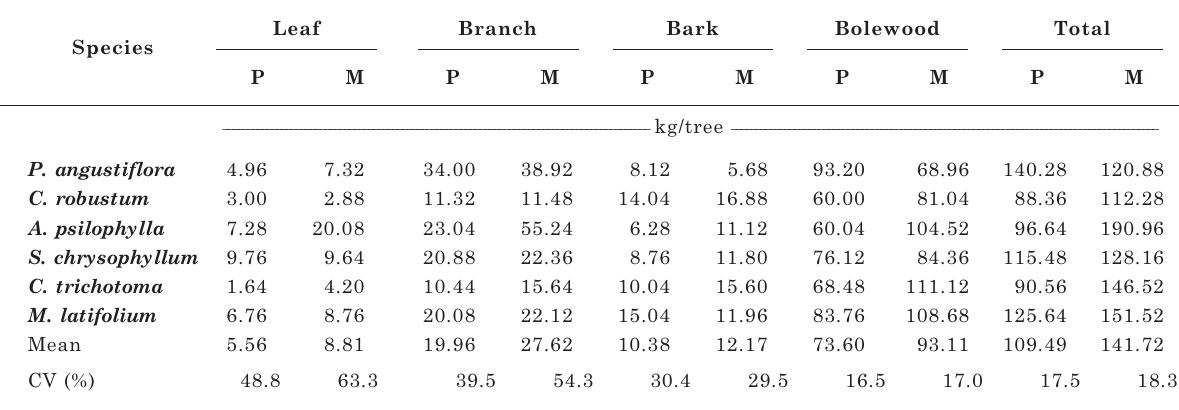
Table 2. Biomass of components of native forest species, in pure (P) and mixed (M) stands